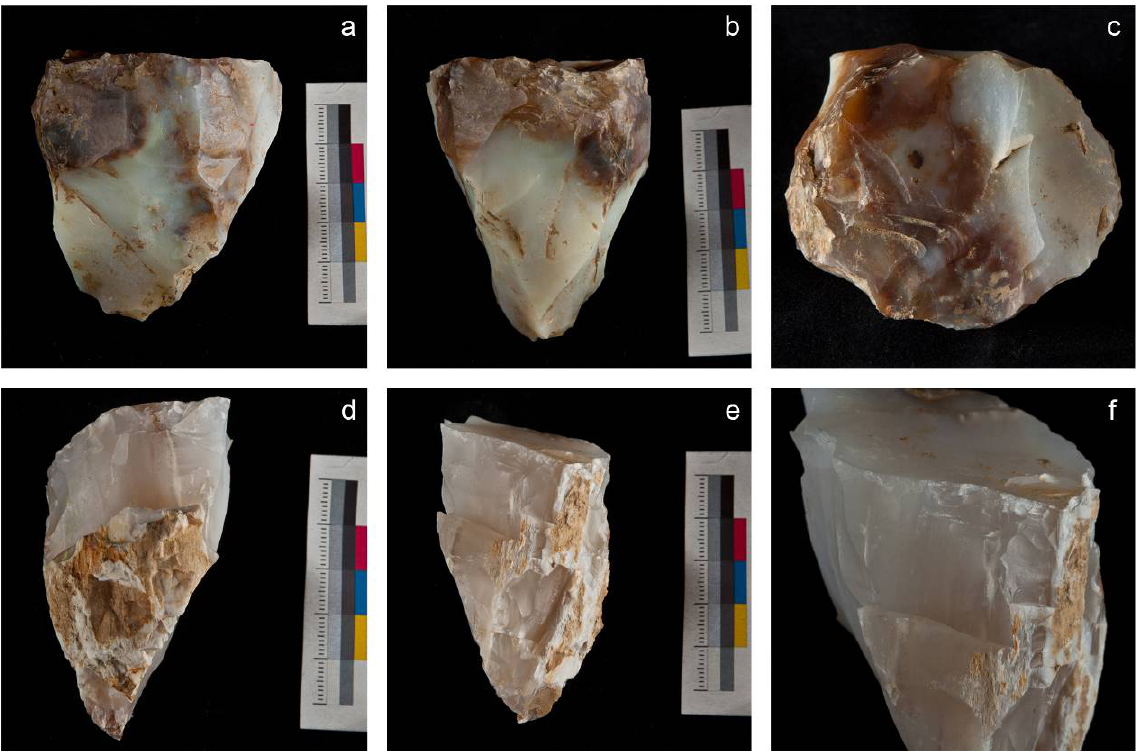
Figure 10. a, b, c - single-platform core from Lojanik workshop 2; d, e, f - new processed core of silicified wood from Lojanik hill (May,